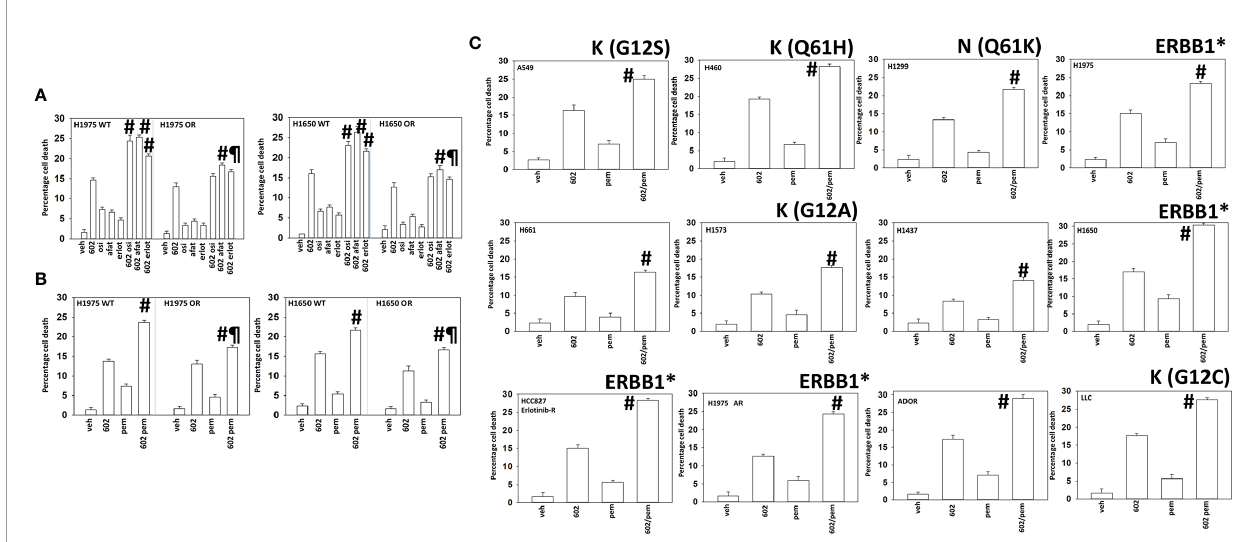
FIGURE 2 | GZ17-6.02 interacts with pemetrexed to kill NSCLC cells. (A) H1975 and H1650 cells [wild-type sensitive and osimertinib resistant (OR)] were treated with vehicle, erlotinib (500 nM), afatinib (500 nM), osimertinib (100 nM), GZ17-6.02 (2 m M curcumin fi nal), or the drugs in combination for 24 h. Cell viability was determined by trypan blue exclusion ( n = 3 ± SD). # p < 0.05 greater than GZ17-6.02 alone; ¶ p < 0.05 less than the corresponding values in drug-sensitive cells. (B) H1975 and H1650 cells [wild-type sensitive and osimertinib resistant (OR)] were treated with vehicle, pemetrexed (500 nM), GZ17-6.02 (2 m M curcumin fi nal), or the drugs in combination for 24 h. Cell viability was determined by trypan blue exclusion ( n = 3 ± SD). # p < 0.05 greater than GZ17-6.02 alone; ¶ p < 0.05 less than the corresponding values in drug-sensitive cells. (C) NSCLC cells were treated with vehicle, pemetrexed (500 nM), GZ17-6.02 (2 m M curcumin fi nal), or the drugs in combination for 24 h. Cell viability was determined by trypan blue exclusion ( n = 3 ± SD). # p < 0.05 greater than GZ17-6.02 alone. The mutational status of K-/N- RAS or of ERBB1 is noted in each graph. * = mutated